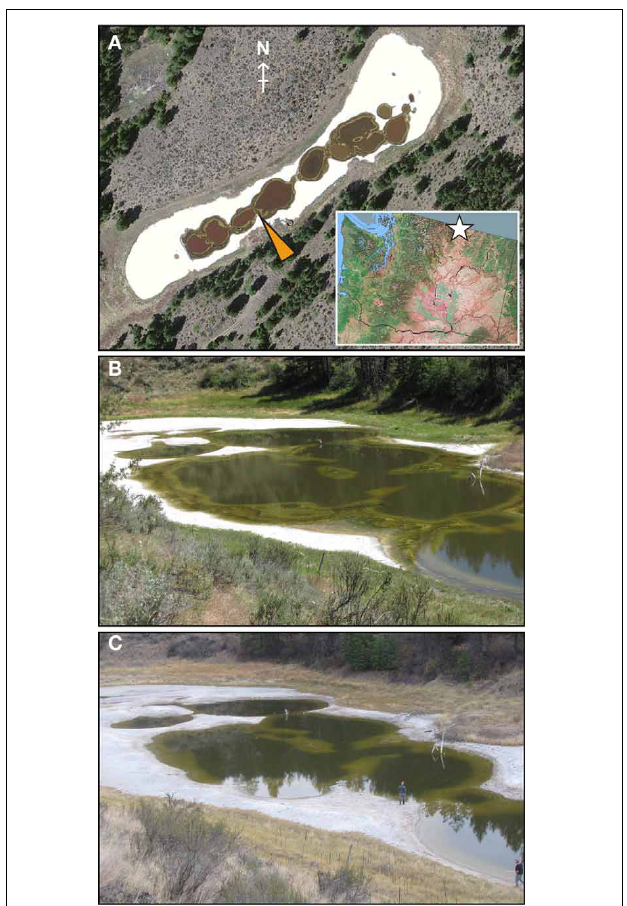
FIGURE 1 | Physical characteristics of Hot Lake. (A) Aerial photograph of Hot Lake on August 6, 2011 showing the surrounding mixed grass and pine communities common within its endorheic basin and the gypsum flats flanking the lake. Mat was sampled at the location indicated by the yellow arrowhead. On the inset map of the state of Washington, the location of Hot Lake is represented by a white star. QuickBird imagery was provided by DigtalGlobe and Land Info Worldwide Mapping, inset map from the National Atlas of the United States. Seasonal changes in water level can be clearly seen from photographs of the north-easternmost basin of Hot Lake taken on July 7, 2011 (B) and October 20, 2011 (C)